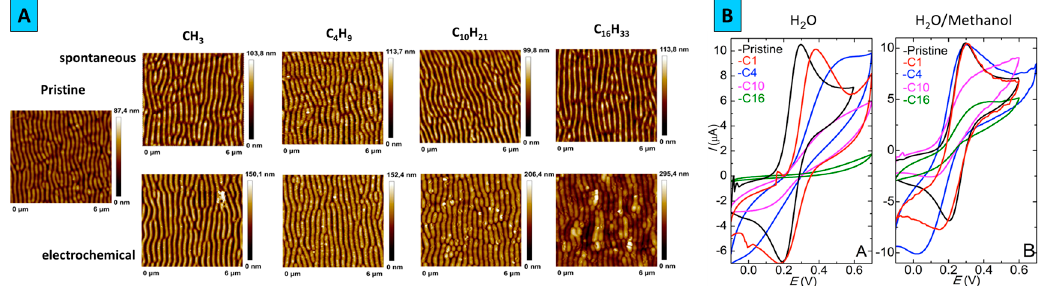
Figure 3. ( A ) Surface topography of pristine and modified by ADTs surfaces, ( B ) Cyclic voltamperometry of pristine and electrochemically modified